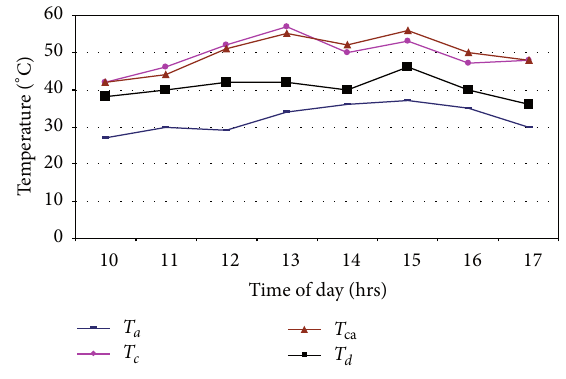
Figure 5: Ambient, collector, collector case, and food cabinet temperatures for Day 4.